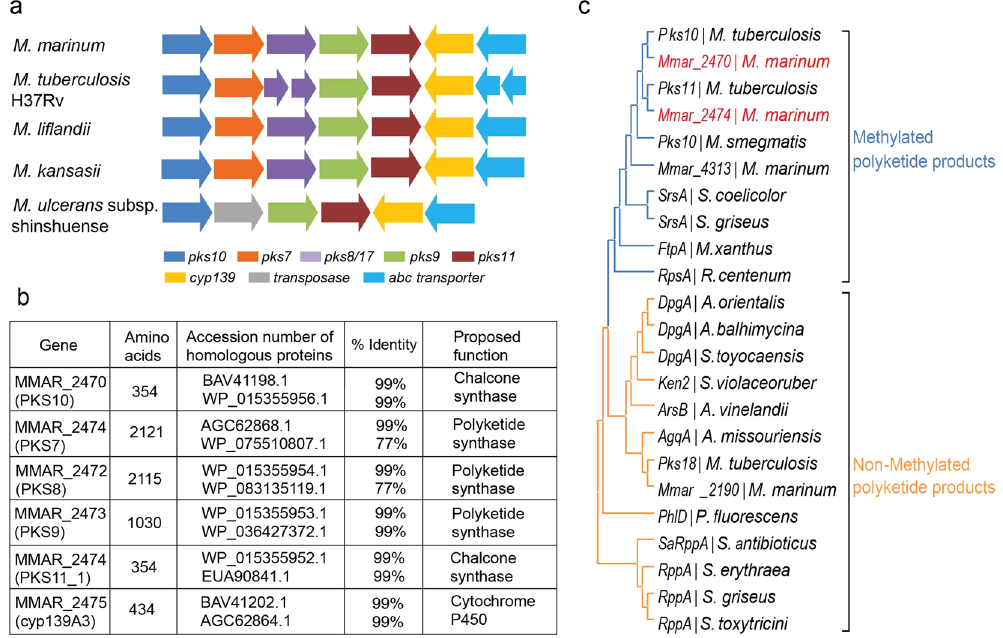
Figure 1. Conservation of 2x type III pks genomic cluster and phylogenetic analysis of M. marinum (Mmar) type III PKSs. ( a ) Conservation of the 2x type III pks genomic cluster in pathogenic mycobacterial species. ( b ) Sequence analysis of Mmar 2x type III pks genomic cluster. ( c ) Phylogenetic analyses of Mmar type III PKS proteins with functionally characterized microbial type III PKSs. Type III PKSs biosynthesizing non-methylated polyketides are represented in orange color, while type III PKSs biosynthesizing methylated polyketide products are represented in blue color. The Mmar type III PKSs discussed in this study are highlighted in red color. The source organism is mentioned along with the protein